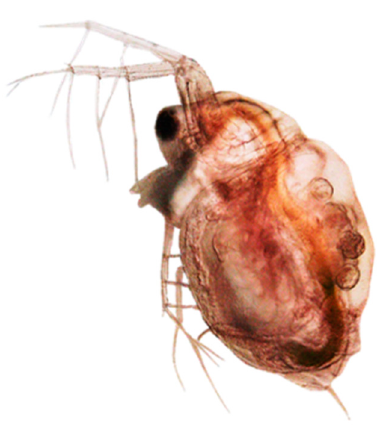
Figure 11. Example of daphnia species recommended for ecotoxicity assessment by standard guidelines: Daphnia magna .